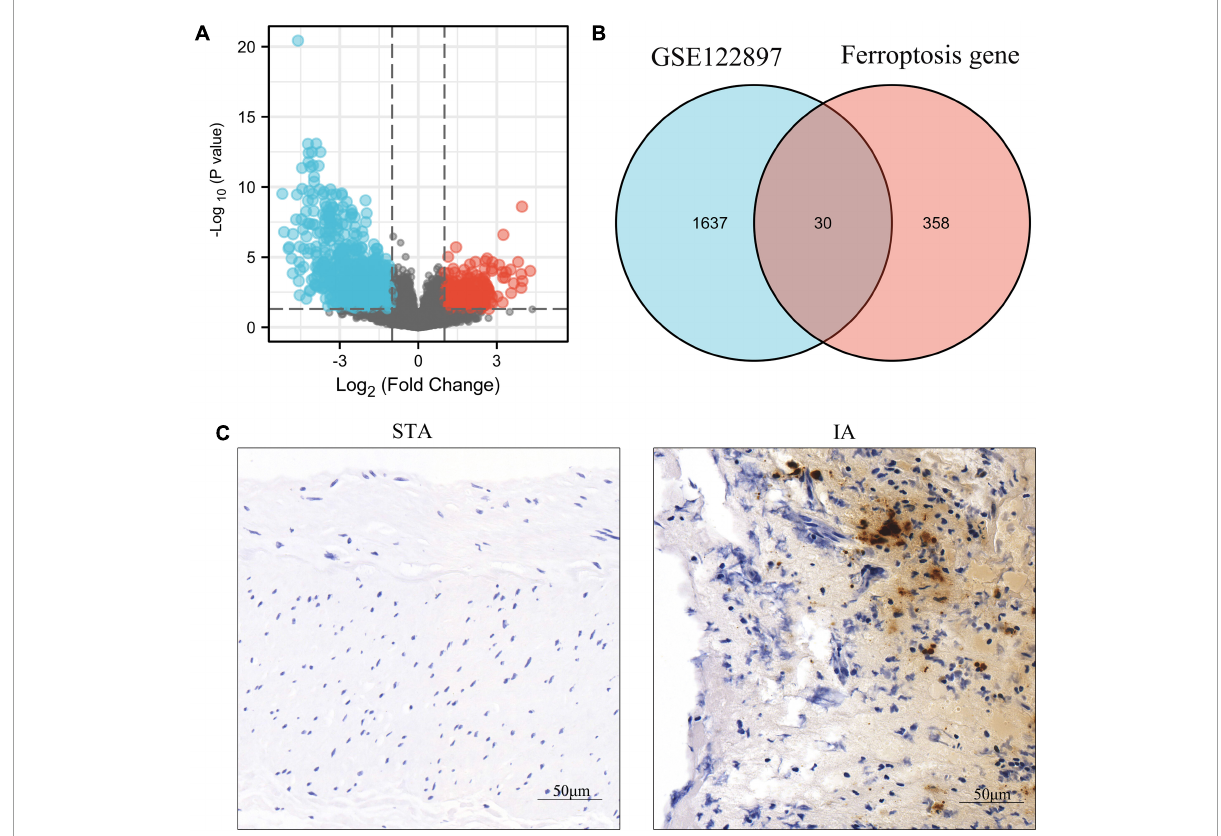
FIGURE2 Identification of ferroptosis-related differentially expressed genes (DEGs) in GSE122897 and detection of iron in tissues. (A) Volcano plot of DEGs. (B) Venn diagram of ferroptosis DEGs. (C) Iron staining within superficial temporal artery (STA) and intracranial aneurysm (IA)